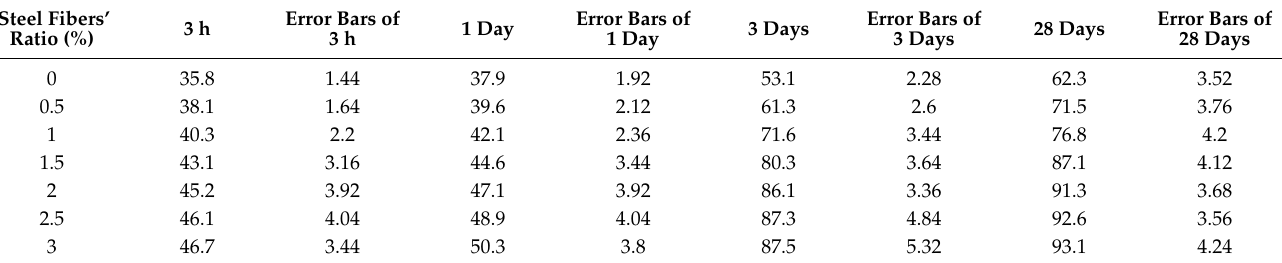
Table A3. The compressive strength of MPC-RPC (MPa).